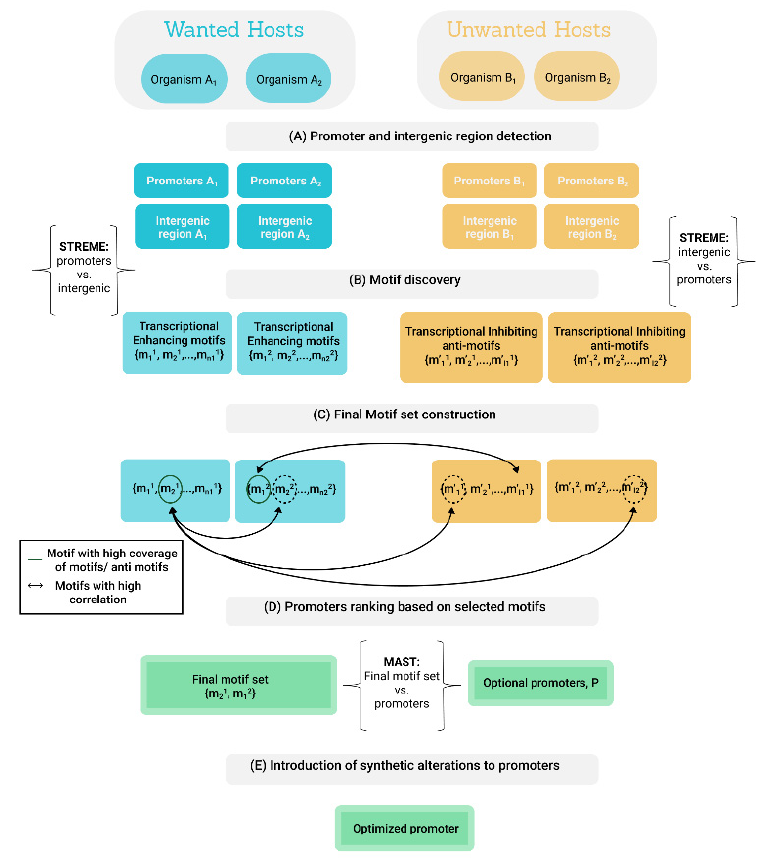
Figure 5. Illustration of transcription optimization algorithm. Promoter and intergenic regions sequences are extracted for every wanted and unwanted host ( A ) and are used as inputs for STREME software tool to find transcription enhancing motifs for wanted hosts and transcription anti-motifs for unwanted hosts ( B ). Transcription enhancing motifs with high correlation to other transcription enhancing motifs and/or other anti-motifs which have the highest coverage for the given microbiome population are chosen for the final motif set ( C ). Motifs in the final motif set are used to score potential candidate promoters using the MAST software tool ( D ). Synthetic promoter versions are created for top ranked promoters to further tailor the sequences based on alignment to the discovered transcription promoting motifs ( E ).